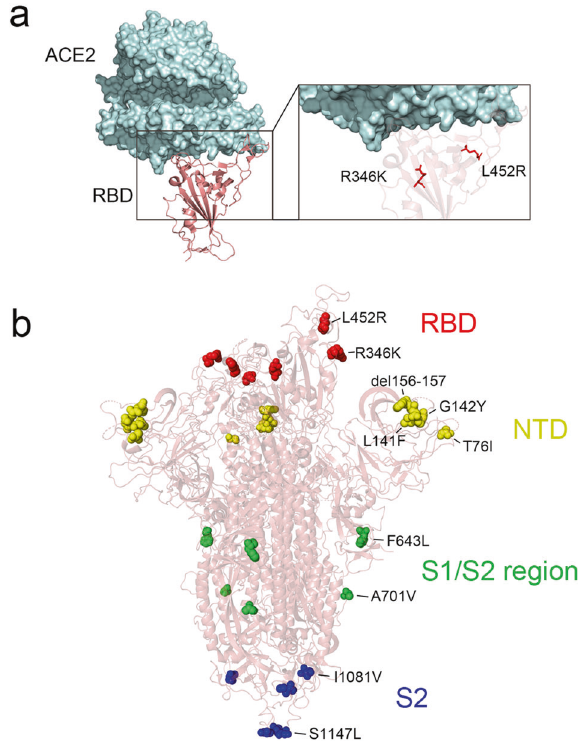
Fig. 2 Structure of the Spike protein with amino acid mutations detected in Omicron BA.1 subvariant. a Structure of human ACE2 receptor complexed with SARS-CoV-2 Omicron RBD, mapped with the recent mutations. b Structure of SARS-CoV-2 Omicron spike protein mapped with the novel mutations. Mutated residues in each domain of the spike protein are annotated in color (red: RBD; yellow: NTD; green: S1/S2; blue: S2) using with Pymol 2.0 software through SARS-CoV-2 Omicron model PDB:7WBL and